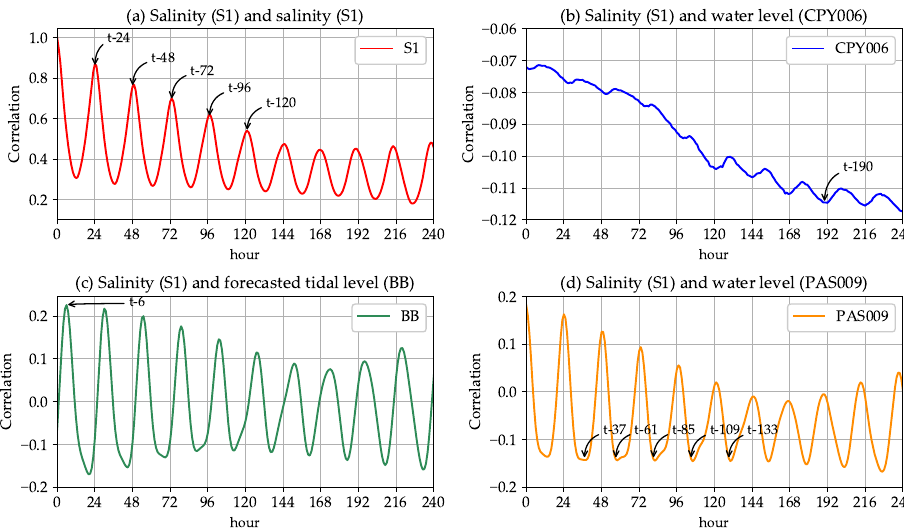
Figure 3. The cross-correlations between S1 and various variables for the low water level case: ( a ) the auto-correlation of S1; ( b ) the cross-correlation between S1 and CPY006; ( c ) the cross-correlation between S1 and BB; and ( d ) the cross-correlation between S1 and